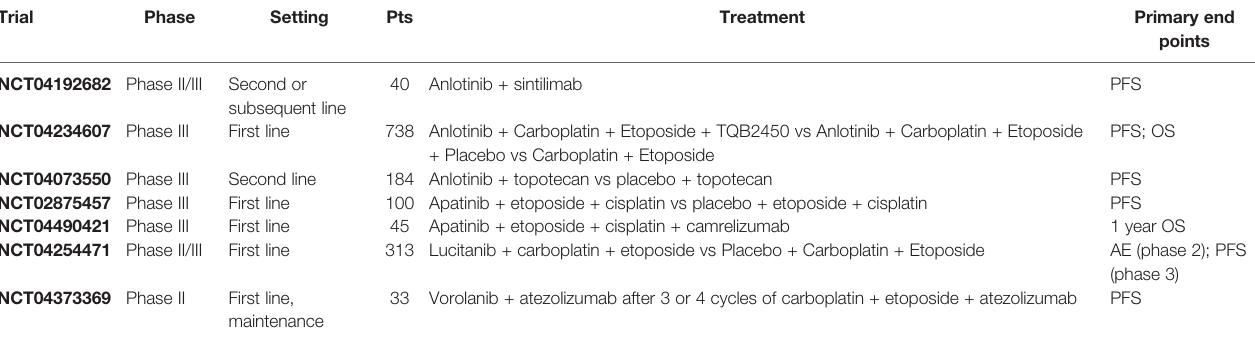
TABLE 3 | Ongoing trials with angiogenesis inhibitors in